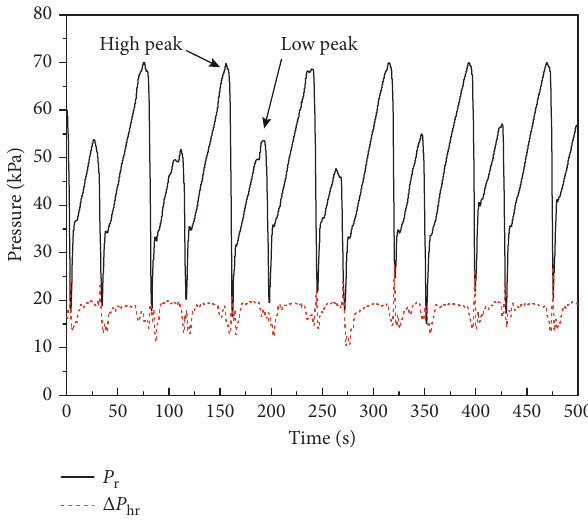
Figure 7: Pressures of P r and Δ P hr for dual-peak